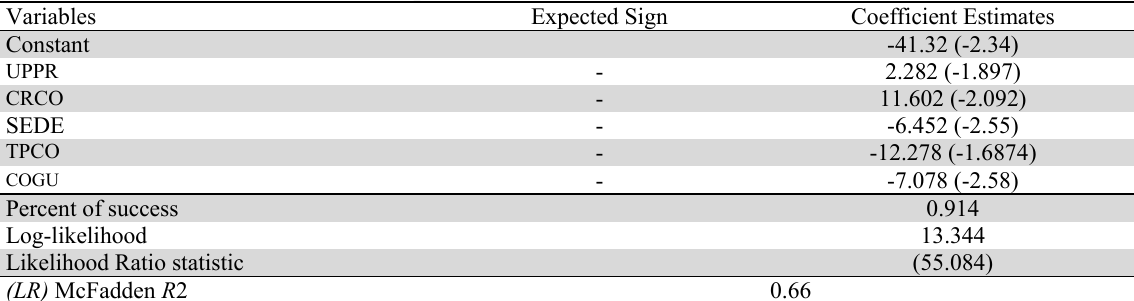
Estimated Coefficients for the Participation Model